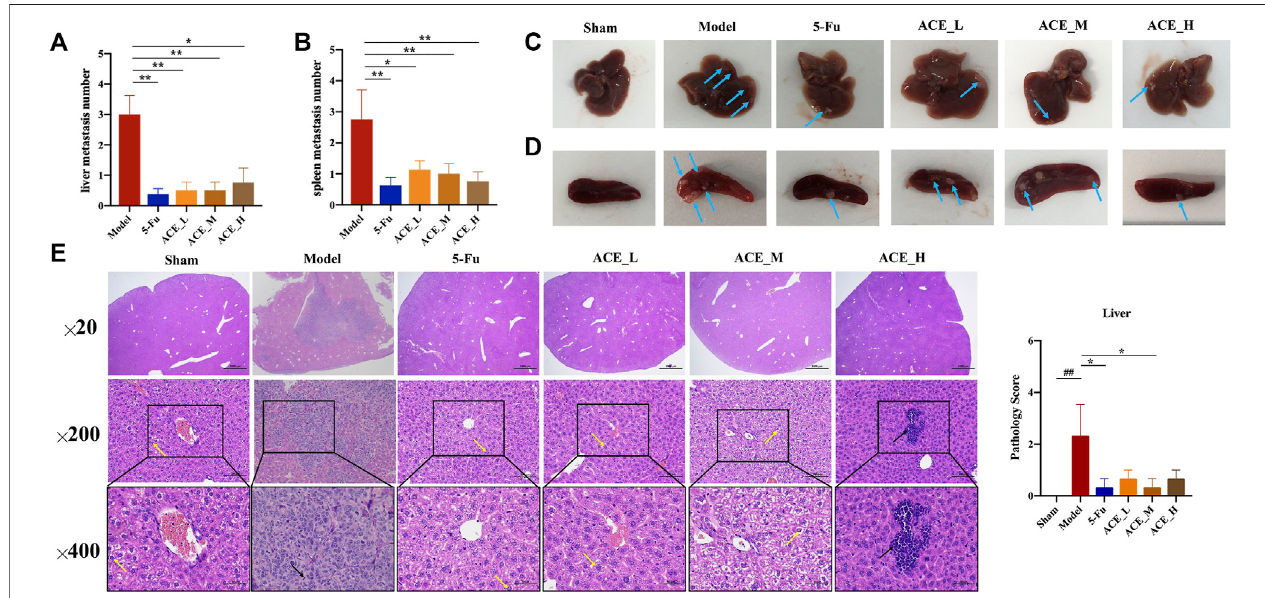
FIGURE 3 | The effect of Astragalus mongholicus Bunge- Curcuma aromatica Salisb. extract on metastases of colon cancer-bearing mice. (A) Liver metastasis number of mice after ACE administration; (B) Spleen metastasis mumber of mice after ACE administration; (C) Pictures of liver metastasis nodules in each group (blue arrows); (D) Pictures of spleen metastasis nodules in each group (blue arrows); (E) Liver metastasis histopathological changes (haematoxylin and eosin (HE) stain). Granular cytoplasm (yellow arrows) and altered nuclear staining (black arrows). ## p < 0.01, compared with the sham group; * p < 0.05, compared with the model group. n (cid:2)